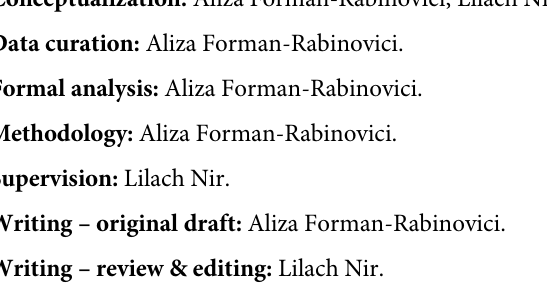
S1 Table. Country list by category. S2 Table. Descriptive statistics for countries by system